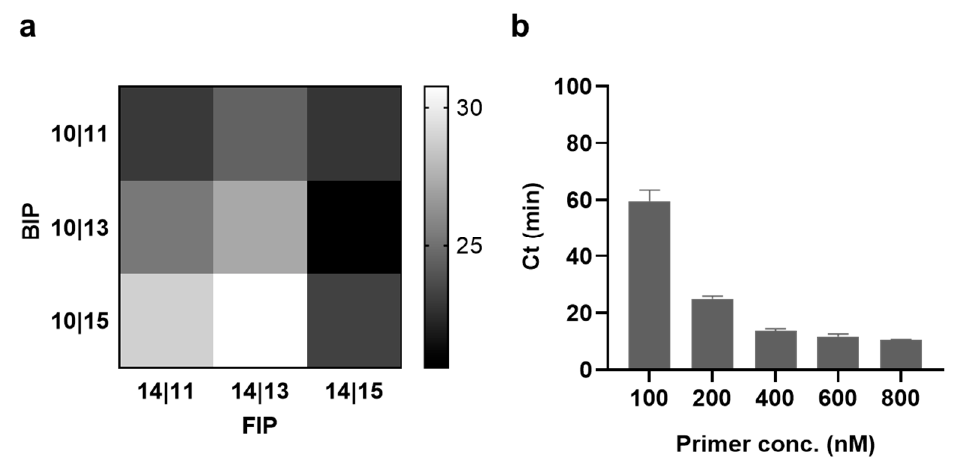
Figure 5. Optimization of hybridization length between primer and loop of SLP. ( a ) Ct values according to the different combinations of the forward inner primer (FIP) and backward inner primer (BIP) (stem hybridization length|loop hybridization length). The concentration of SLP (RL15) was 50 pM. ( b ) Ct values according to the different concentrations of primers. The concentration of RL15 was 50 pM. All tests were performed with three technical replicates.